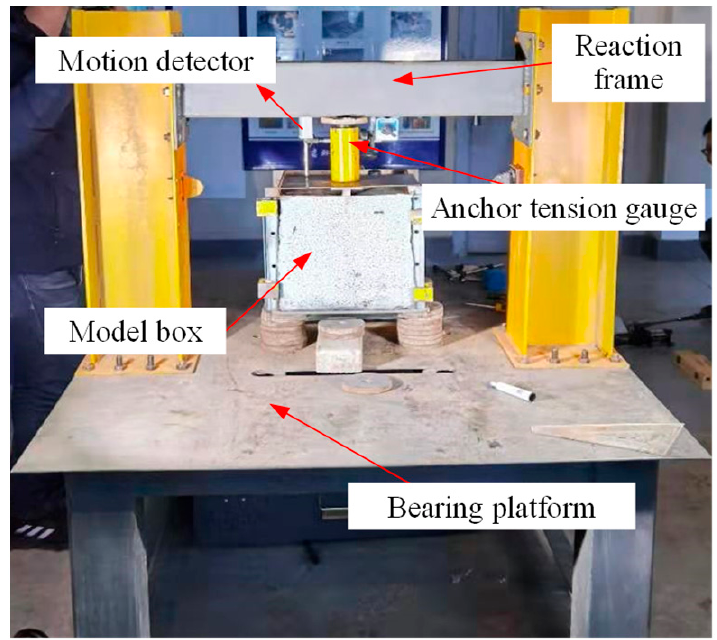
Figure 6. Loading platform.